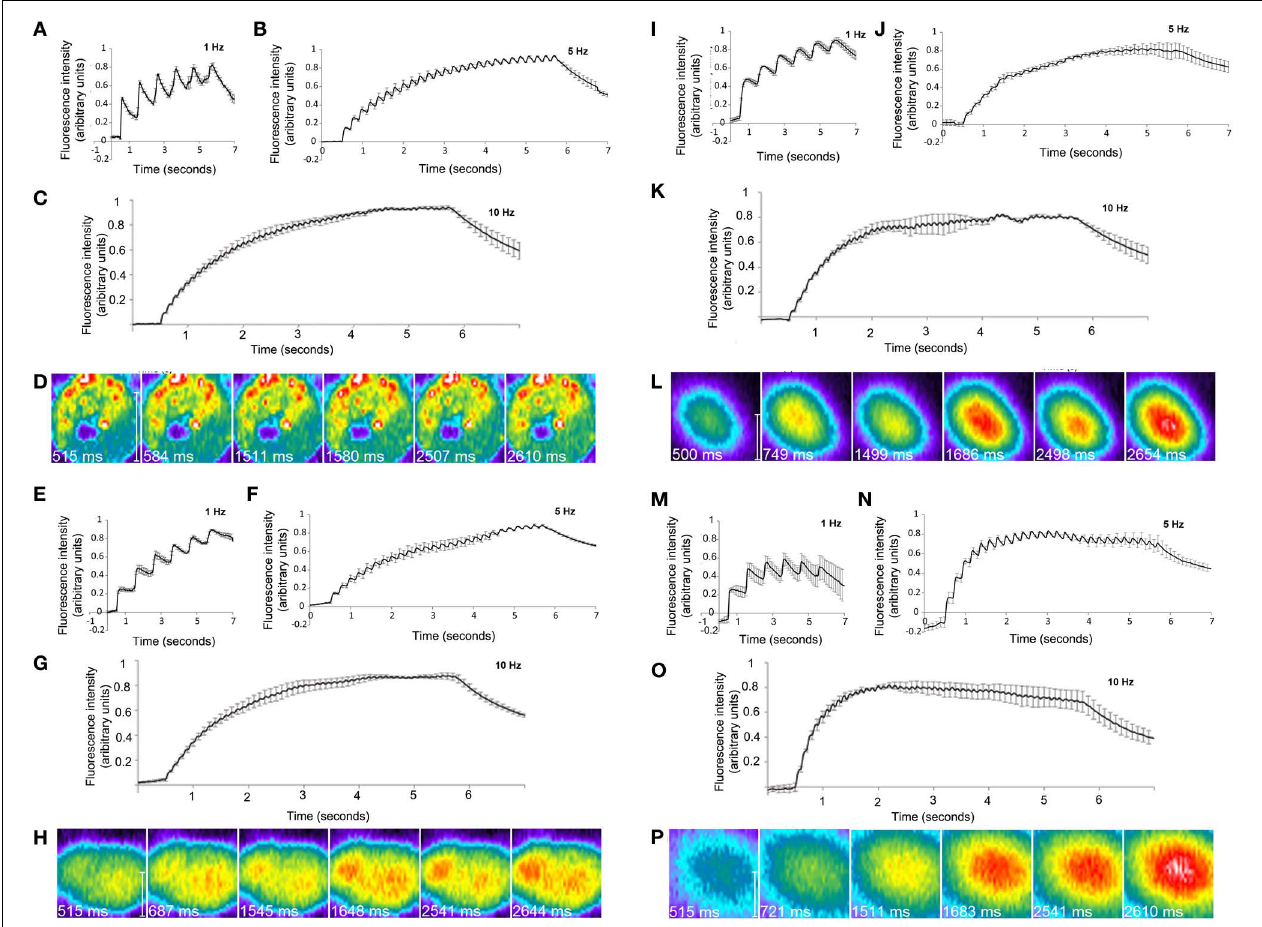
FIGURE 4 | Calcium imaging frequency response of cultured rat cortical neurons with field stimulation or photostimulation. (A) Fluo-4 calcium imaging intensity of cultured cortical neurons in response to 5s of 1Hz (B) 5Hz and (C) 10Hz field stimulation. ( n = 50 neurons/1Hz, 56 neurons/5Hz, 47 neurons/10Hz) (D) Rainbow colormap images of fluo-4 based calcium response from one cell undergoing 1Hz field stimulation. Fluo-4 calcium imaging intensity response of neurons to 5s of 1Hz 5Hz and 10Hz photoconductive stimulation on (E–G) polished silicon ( n = 37 cells/1Hz, 48 cells/5Hz, 51 neurons/ 10Hz), (I–K) porous oxidized silicon